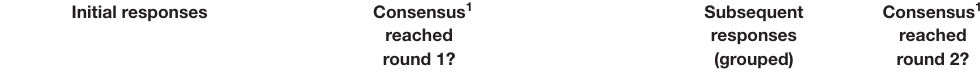
TABLE 2 | Expert panel